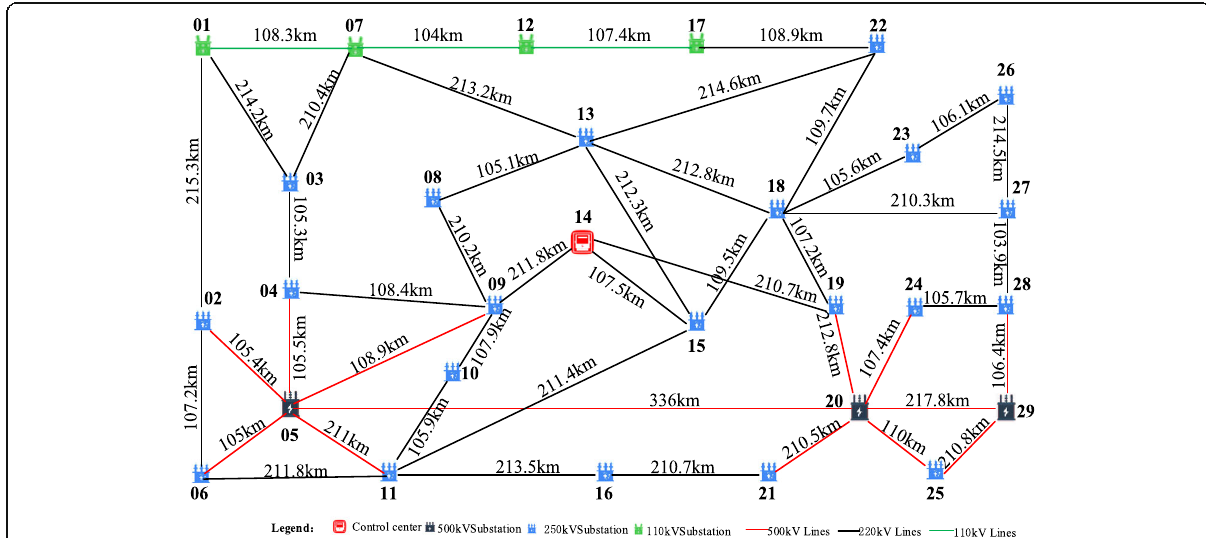
Fig. 6 Networking topology in some province of China [42]. This figure provides the experimental topology. The nodes denote substations with different voltage levels and have different node importance. They are highlighted in different colors. Likewise, the links connect different substations with different link importance